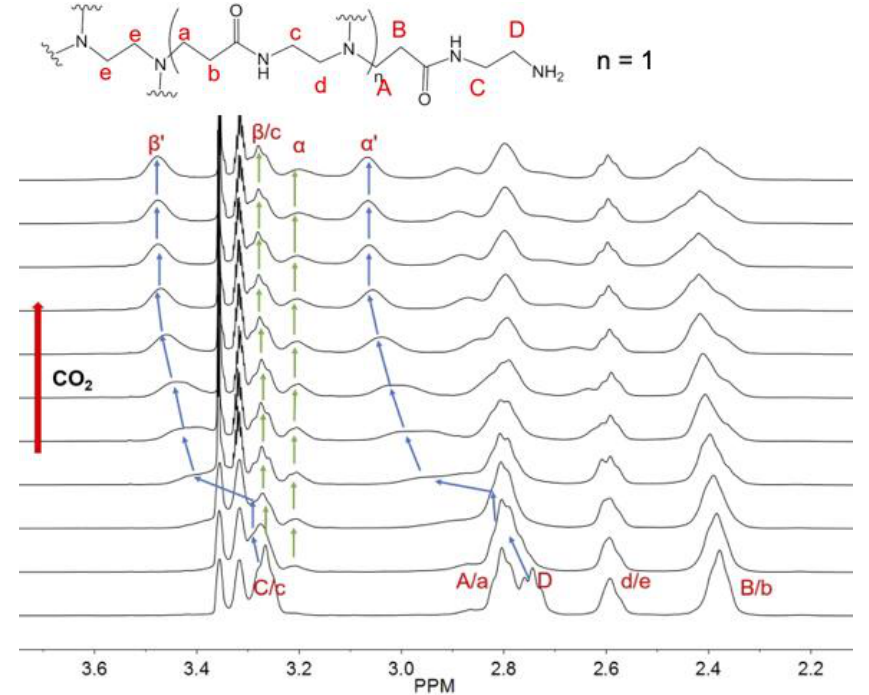
Figure 4. 1 H NMR spectra (400 MHz, CD 3 OD) of G1 dendrimer (0.02 M) upon addition of CO 2 (g) to the solution. As in the two previous figures, the terminal methylene protons of the ammonium branches are labeled β’ and α’ and those of the carbamate branches are labeled β and α . The blue arrows follow the development of ammonium branch signals while green arrows follow the development of carbamate branches.